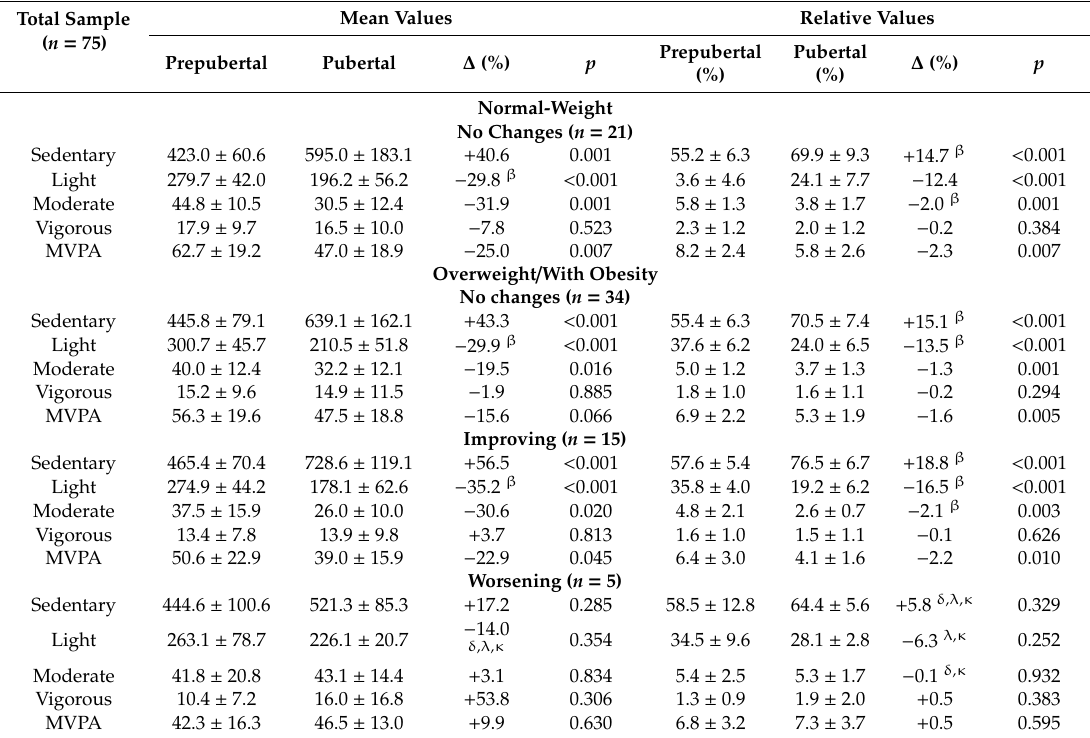
Table 5. Comparison of physical activity levels between prepubertal and pubertal periods according to BMI-change groups in the longitudinal sample (n =